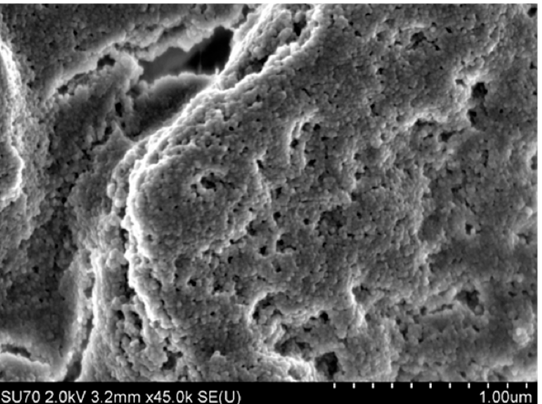
Figure 14. ZrO 2 powder grain surrounded by silica nanoparticles from the Ludox SK binder.